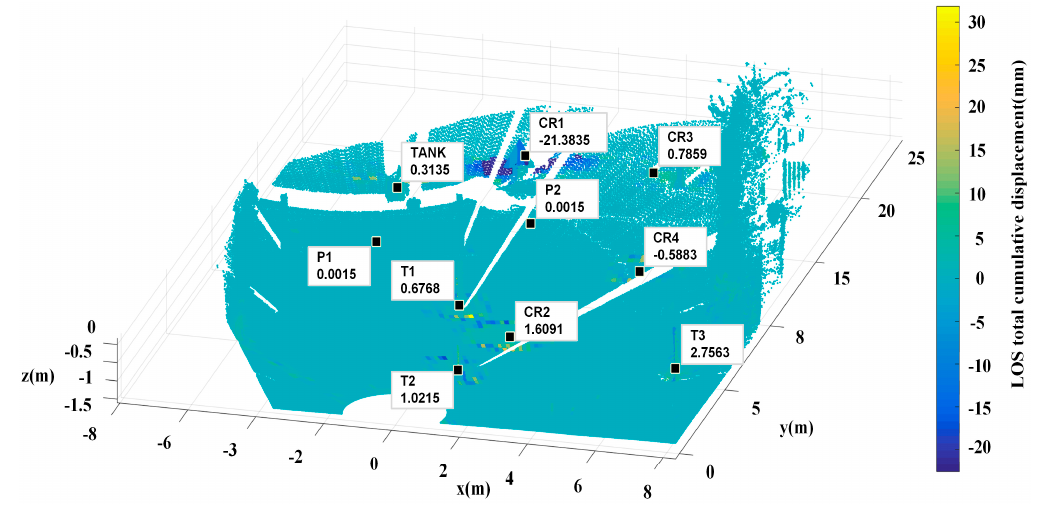
Figure 16. Filtered 3D total cumulative displacement map. Abnormal areas shown in Figure 8 were filtered (P1 and P2). T1, T2 and T3, which within highlighted regions in Figure 11a, stand for the trunks.